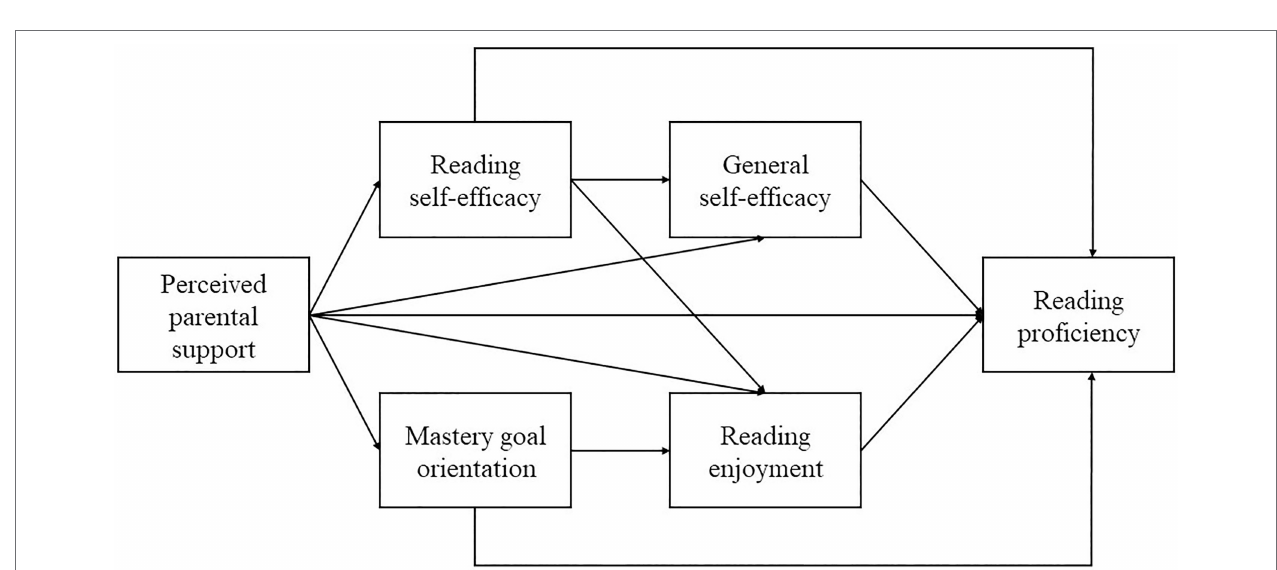
FIGURE 2 | Hypothesized model (Model 2 ) consistent with bottom-up